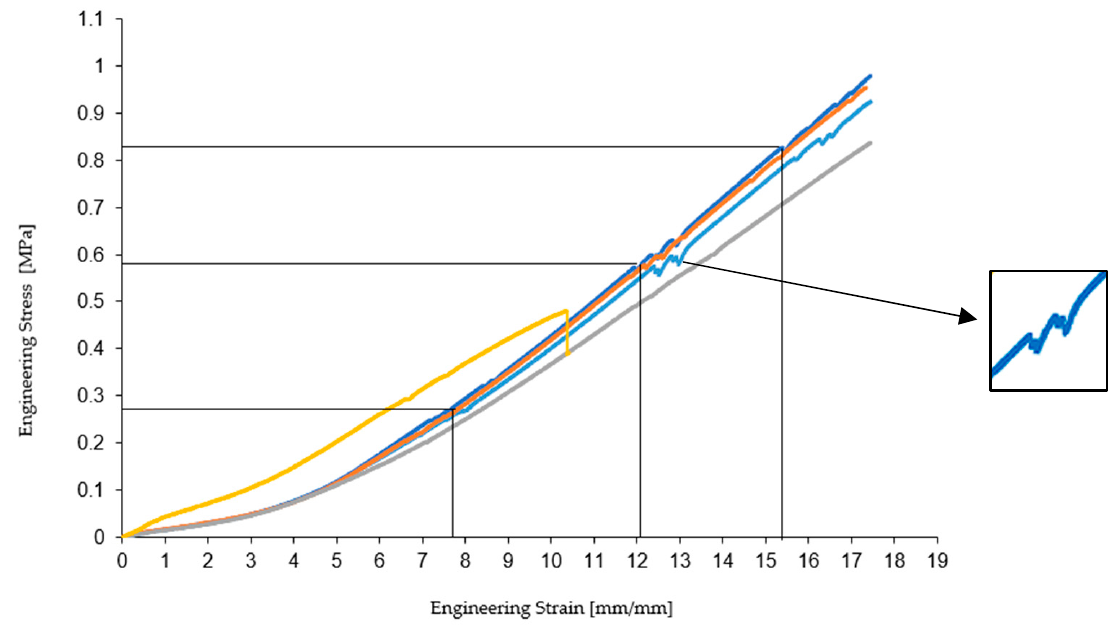
Figure 10. Deviations on characteristic curve.